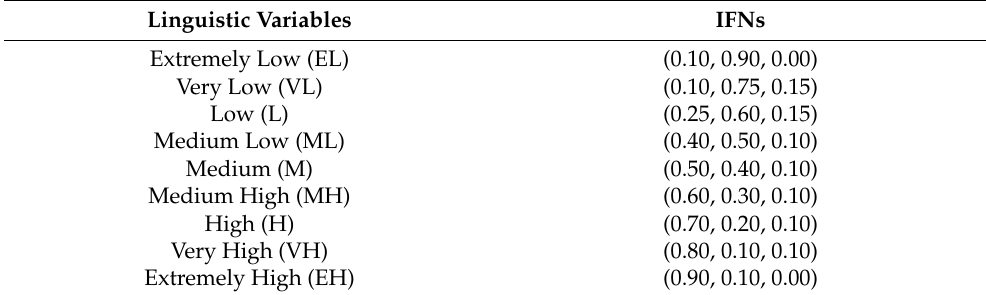
Table 1. The transformation relationship of decision-making matrix linguistic variables